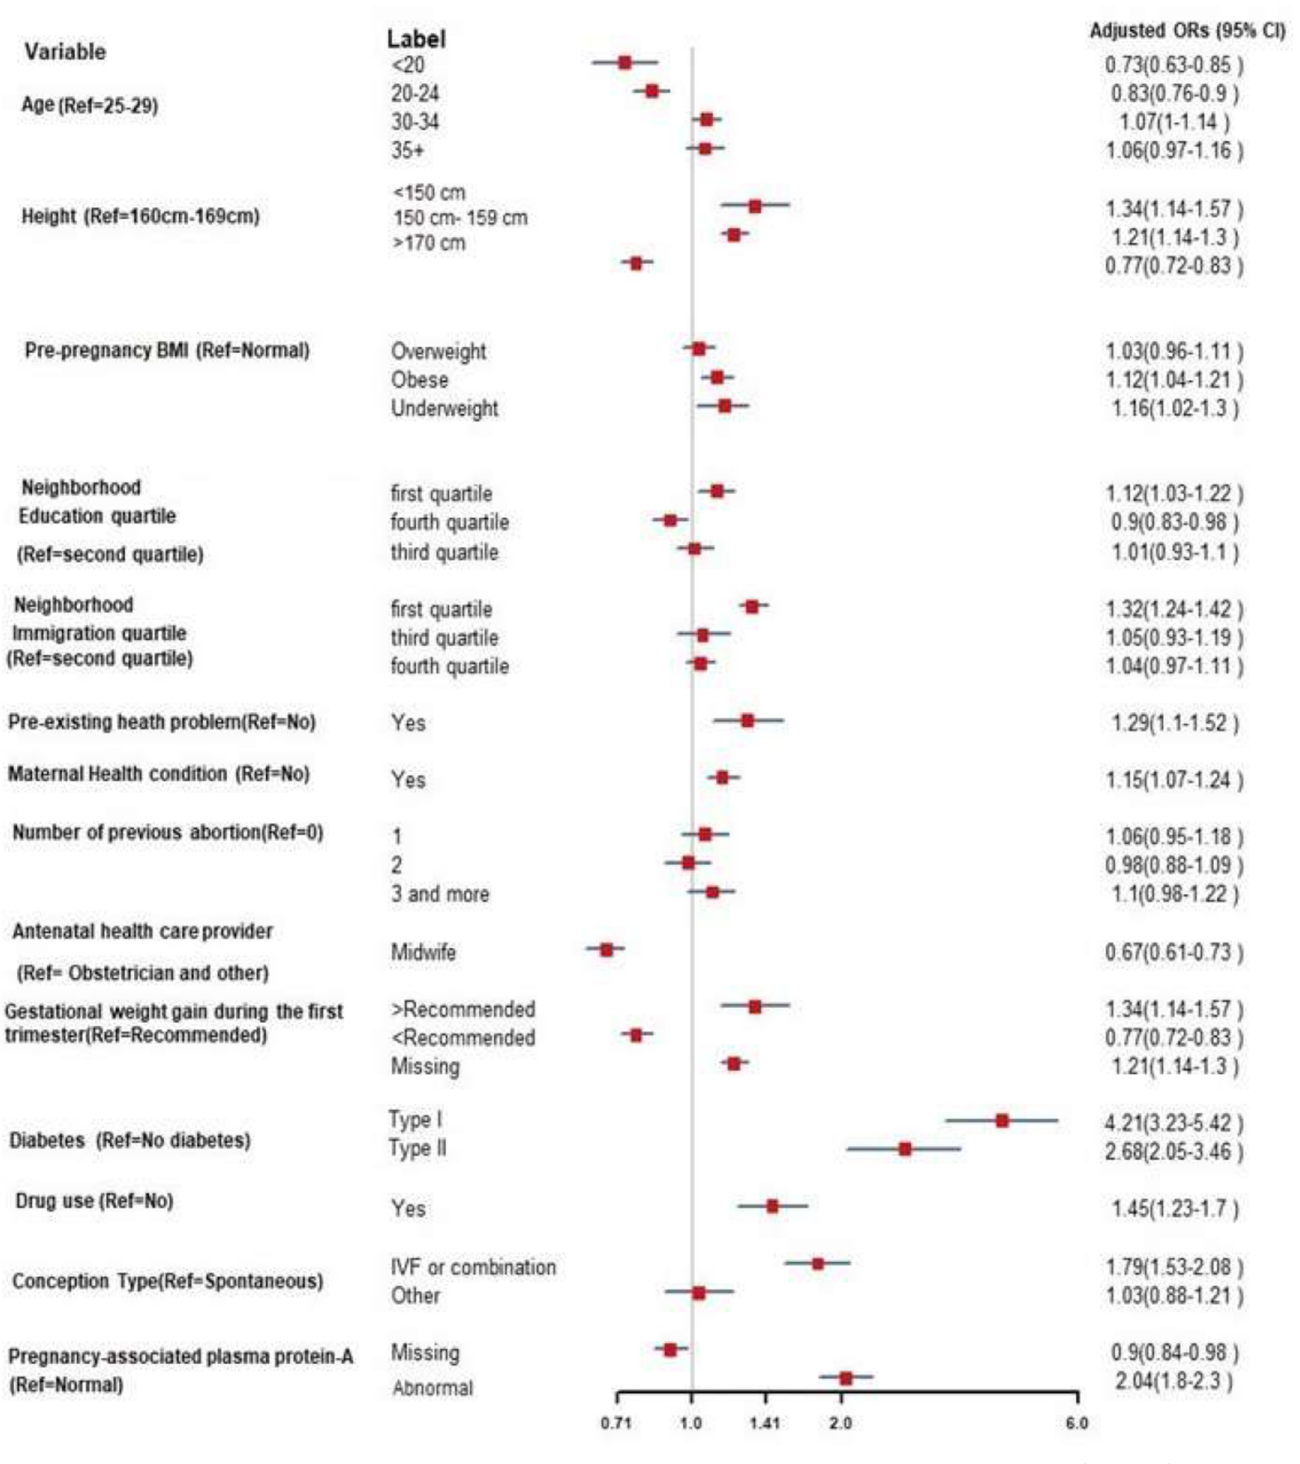
Fig 2. Selected variables and odds ratios during the second trimester for prediction of preterm birth in nulliparous women. BMI: Body mass index; IVF: In vitro fertilization; Ref: Reference group; Pre-existing maternal health conditions shown in S2 Table. Pre-existing mental health conditions shown in S3 Table. Number of previous abortions: includes the number of miscarriages.